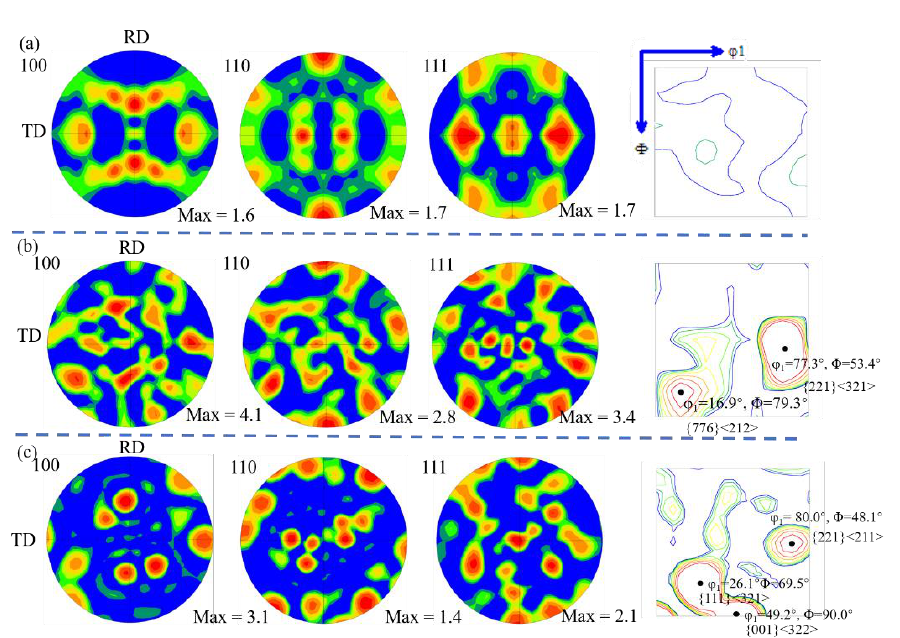
Figure 6. Deformation textures of the studied samples represented by pole figures and ODF section: